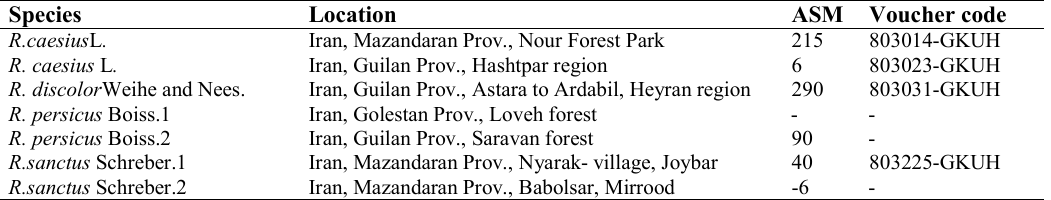
Table 1. Collection data of studied specimen or population properties. Species Location ASM Voucher